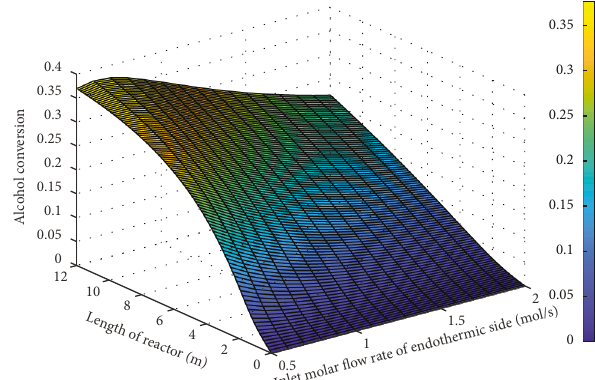
Figure 7: Effect of molar flow rate on the exothermic side of the reactor on conversion percentage of 2-butyl alcohol and MEK